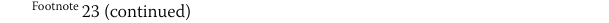
EW are the Euler (cid:31)